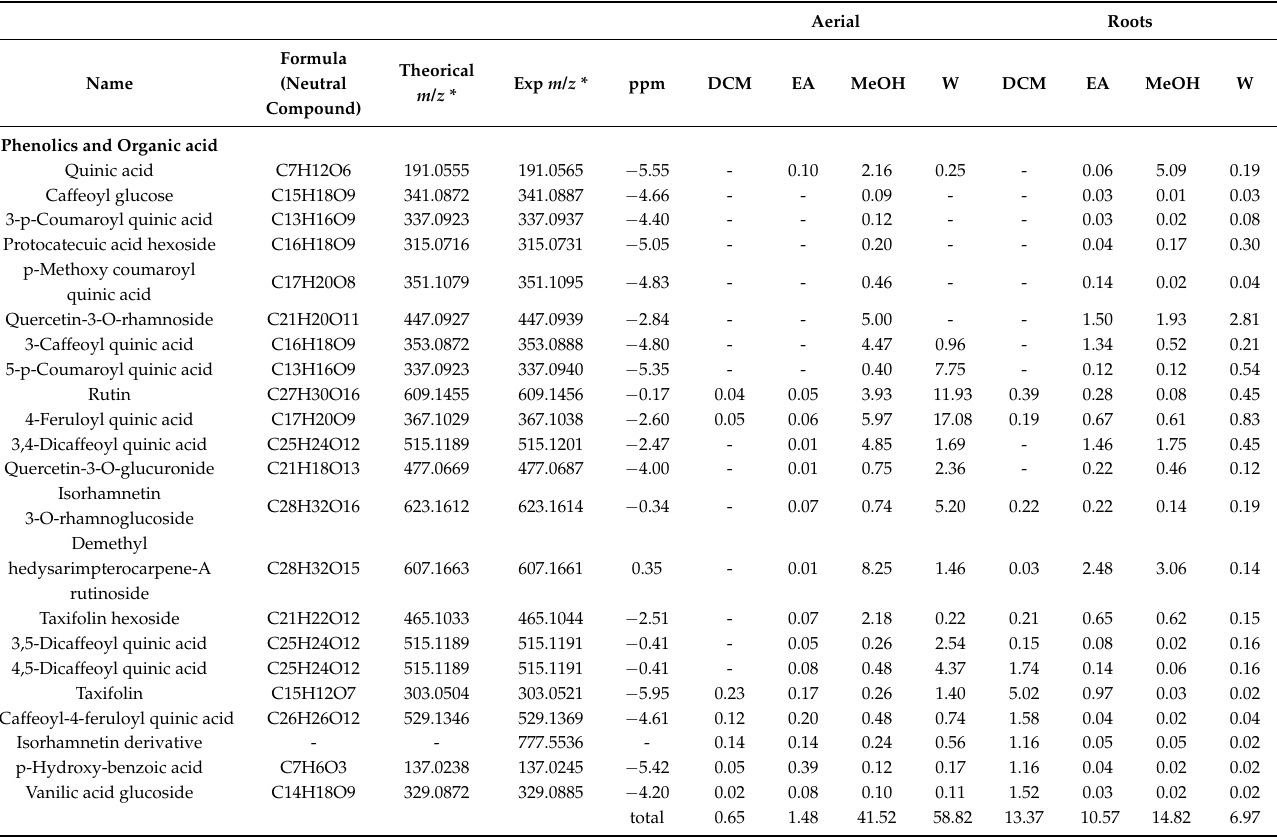
Table 3. Content of phenolic and organic acids identified in the extracts, expressed as mg/g of dry extract. MS data were acquired in negative ion mode (ESI( − )).